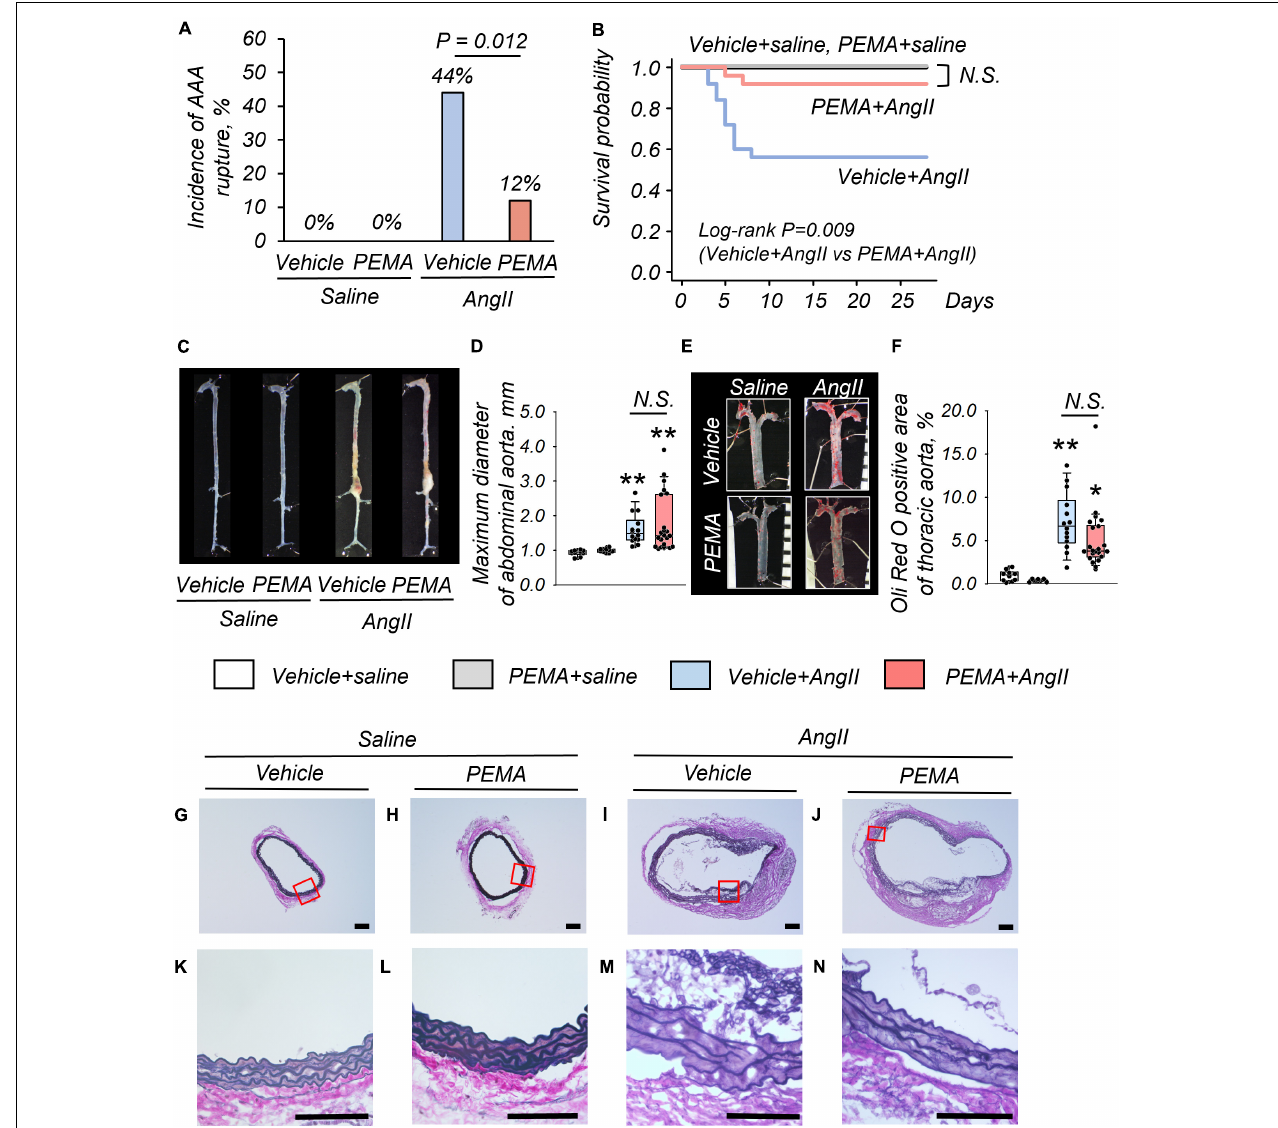
FIGURE 2 | Impact of pemafibrate (PEMA) on abdominal aortic aneurysm (AAA) in a murine model. Incidence of aortic rupture in the vehicle-treated saline-infused (vehicle + saline) ( n = 10), PEMA-treated saline-infused (PEMA + saline) ( n = 10), vehicle-treated angiotensin II-infused (vehicle + AngII) ( n = 25), and PEMA-treated angiotensin II-infused (PEMA + AngII) ( n = 25) groups (A) . Kaplan–Meier survival curve for AngII- or saline-infused mice in the presence or absence of PEMA (B) . Representative findings of aortas (C) and maximum diameter of suprarenal abdominal aortas (D) extracted from surviving mice. Representative findings of Oil Red O staining (E) and Oil Red O-positive area (F) of thoracic aortas extracted from surviving mice [ n = 10 (vehicle + saline group), n = 10 (PEMA + saline group), n = 14 (vehicle + AngII group), and n = 22 (PEMA + AngII group)]. Representative results of Elastica van Gibson staining (G–N) . Data are expressed as frequencies for categorical variables and analyzed by chi-square test (A) or as median (interquartile range) and analyzed using the Kruskal–Wallis test followed by Bonferroni corrections (D,F) . Survival probabilities were compared using the log-rank test (B) . * p < 0.01 vs. vehicle + saline group; ** p < 0.001 vs. vehicle + saline. N.S., not significant. Scale bar = 100 µ